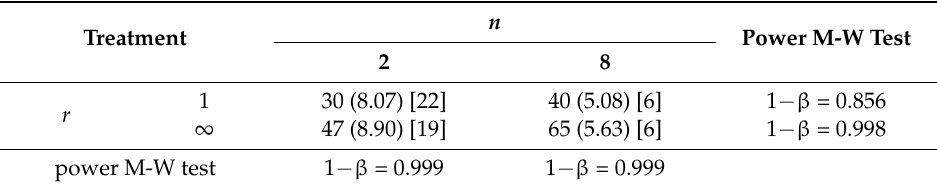
Table A1. Statistical power of the